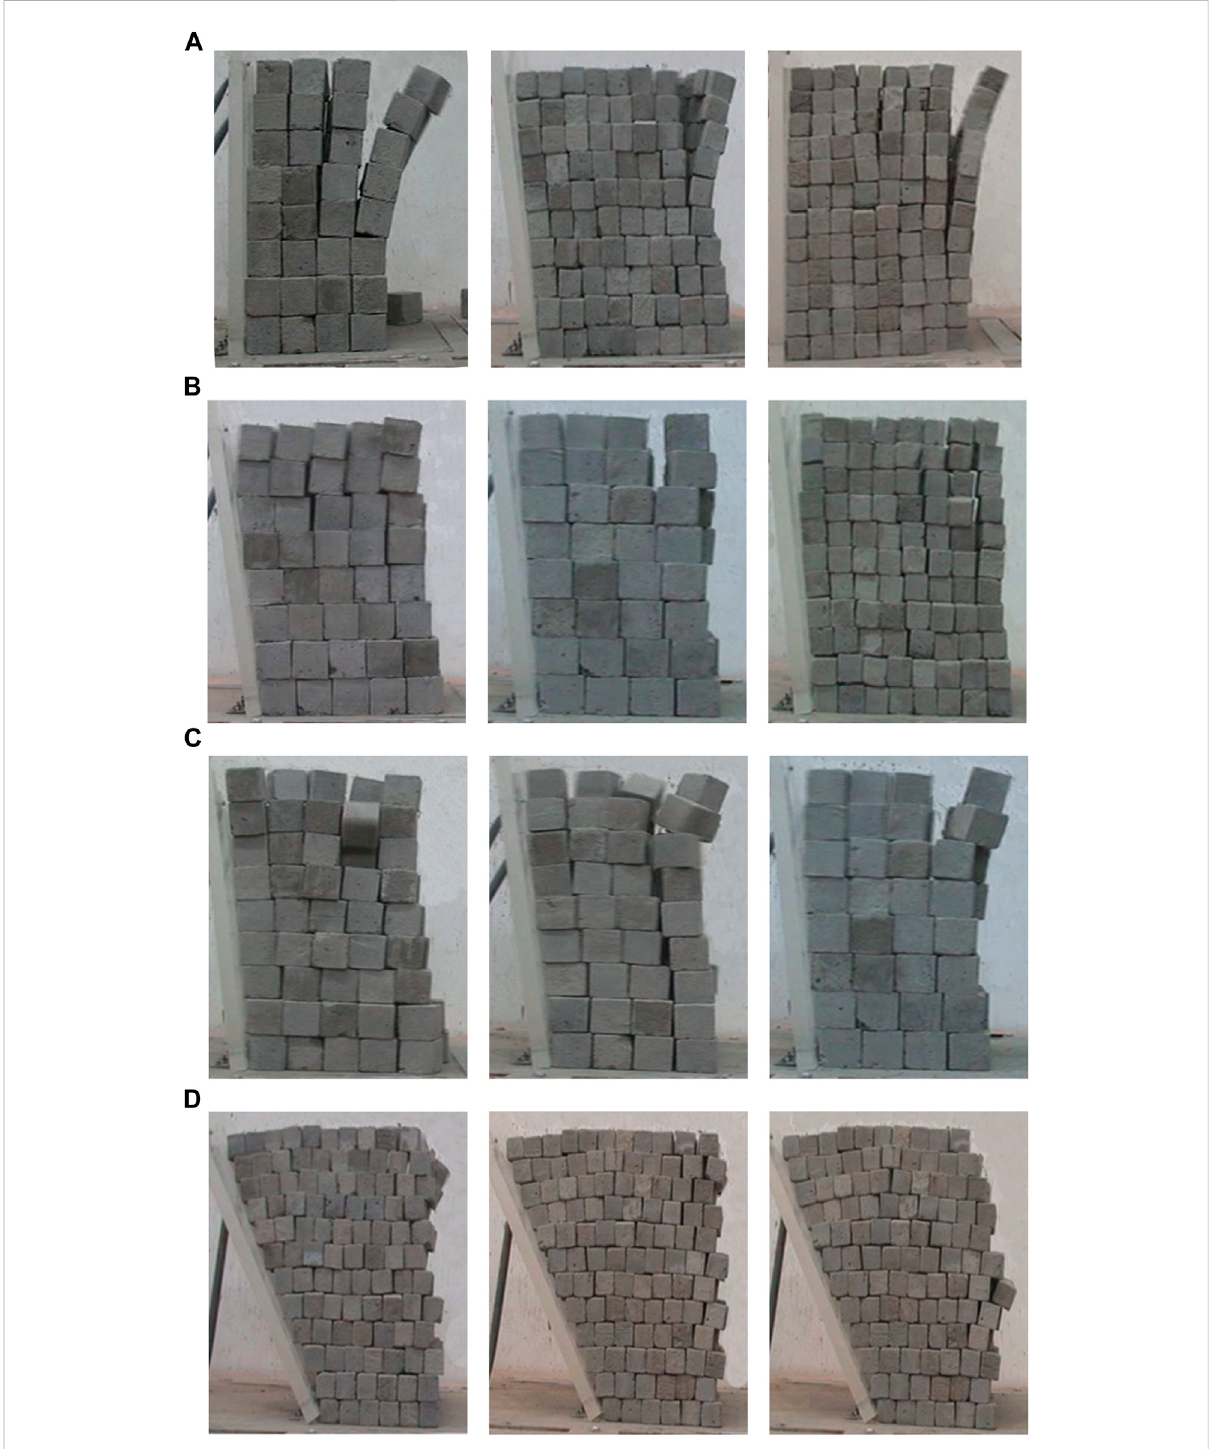
FIGURE 8 Failure motion patterns of dangerous rock block during shaking table experiments. (A) Rotational motion pattern of sequential collapse. (B) Translational motion pattern of sequential collapse. (C) Hybrid motion pattern of sequential collapse. (D) Sliding and exfoliation failure